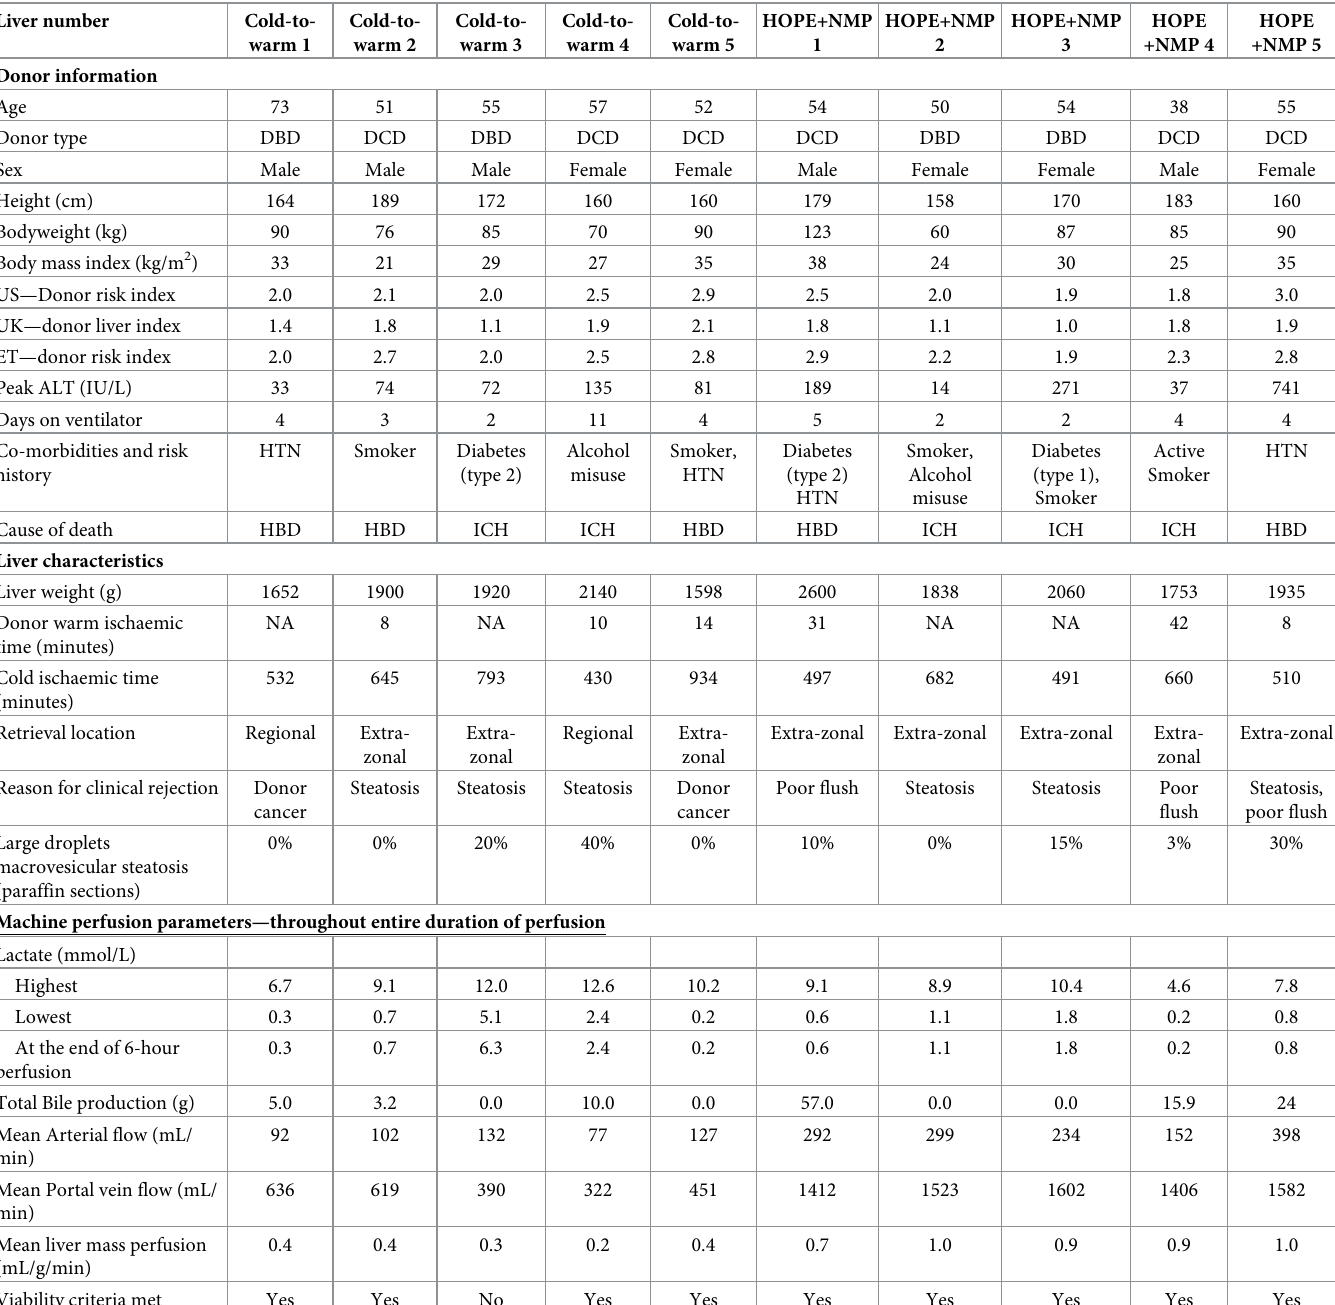
Table 1. Donor demographics, liver characteristics and machine perfusion